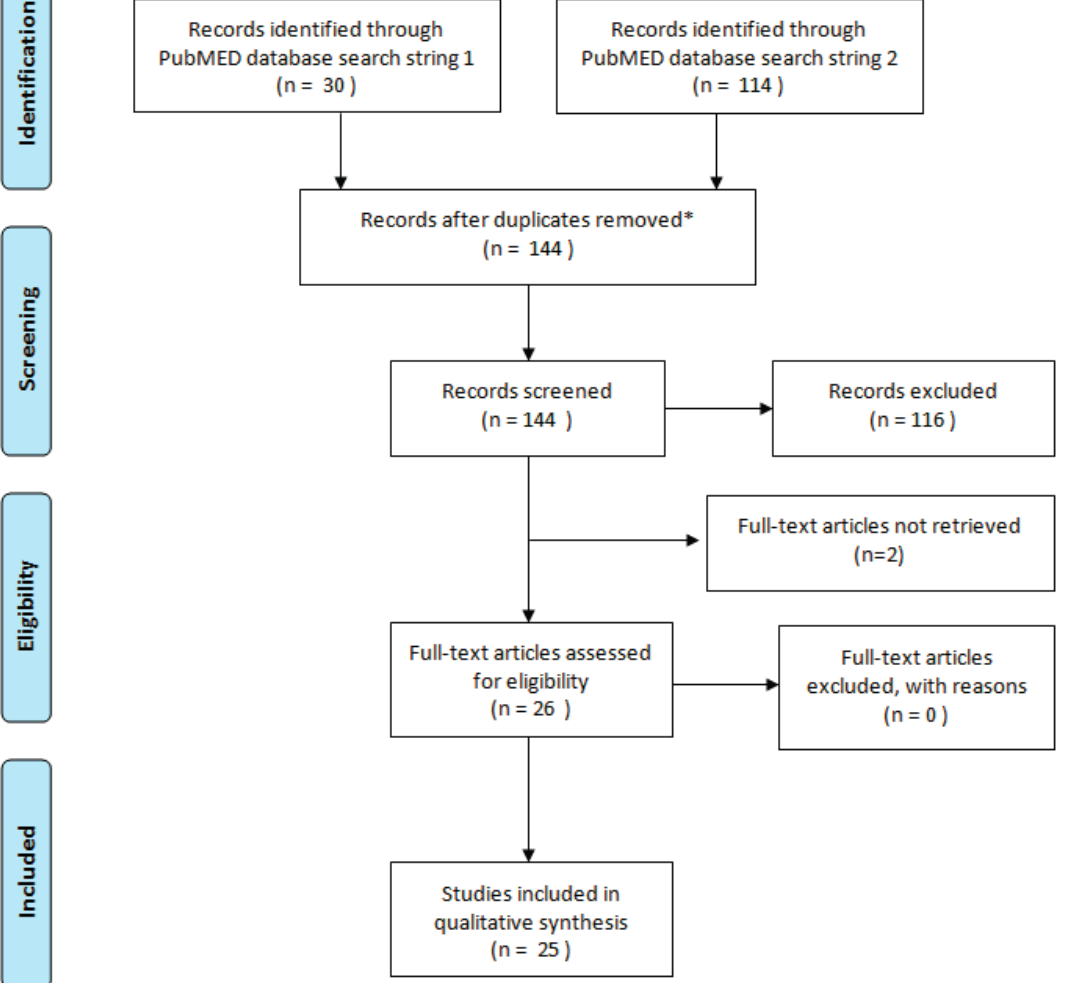
Figure 2. Flow Diagram of the systematic review (modified from PRISMA (Preferred Reporting Items for Systematic Reviews and Meta-Analyses) statement